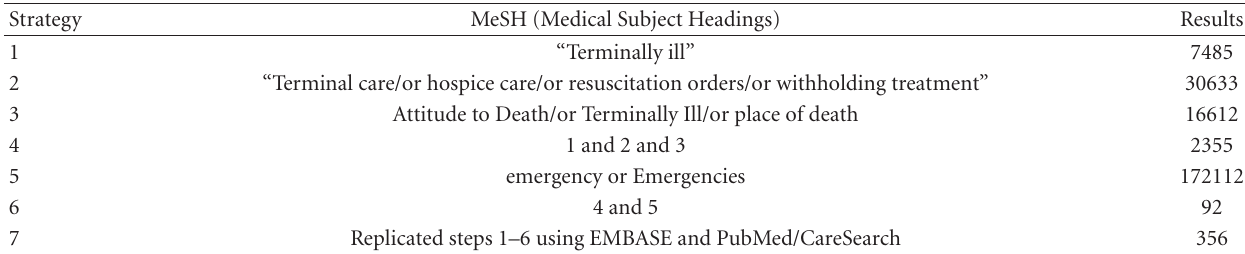
Table 1: Terms used in the literature review (updated August